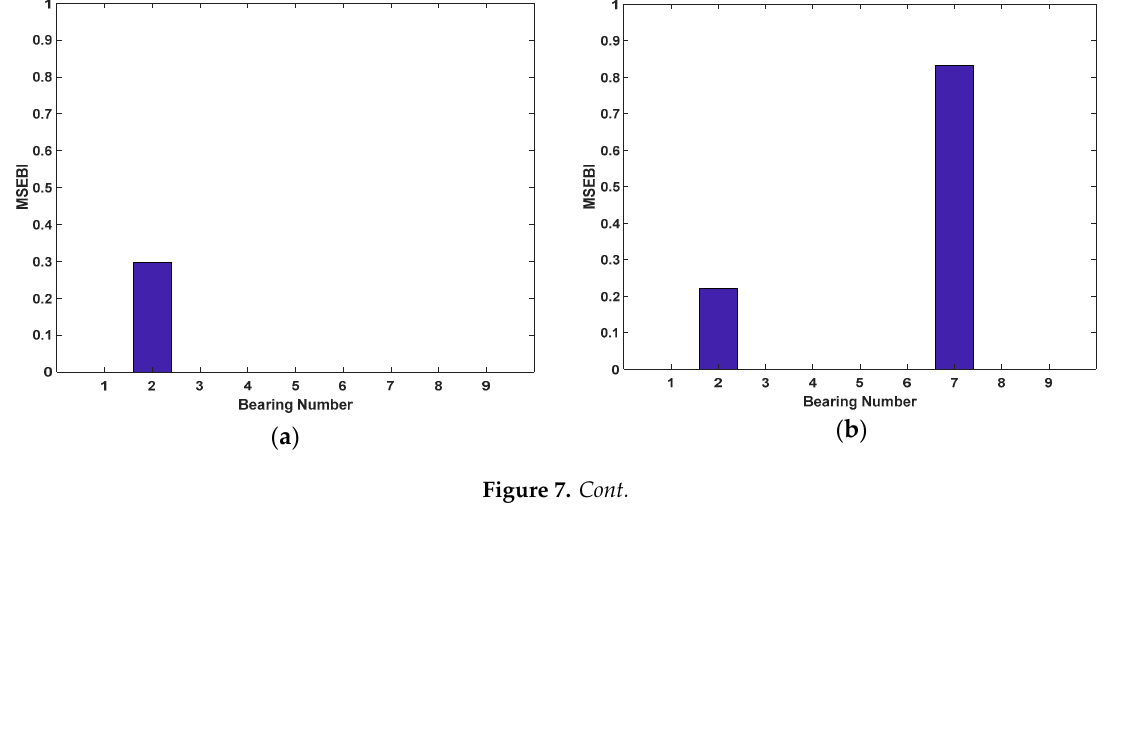
Figure 6. Results of structural elements damage location: ( a ) Case 1; ( b ) Case 2; ( c ) Case 3; ( d ) Case 4; and ( e ) Case 5.